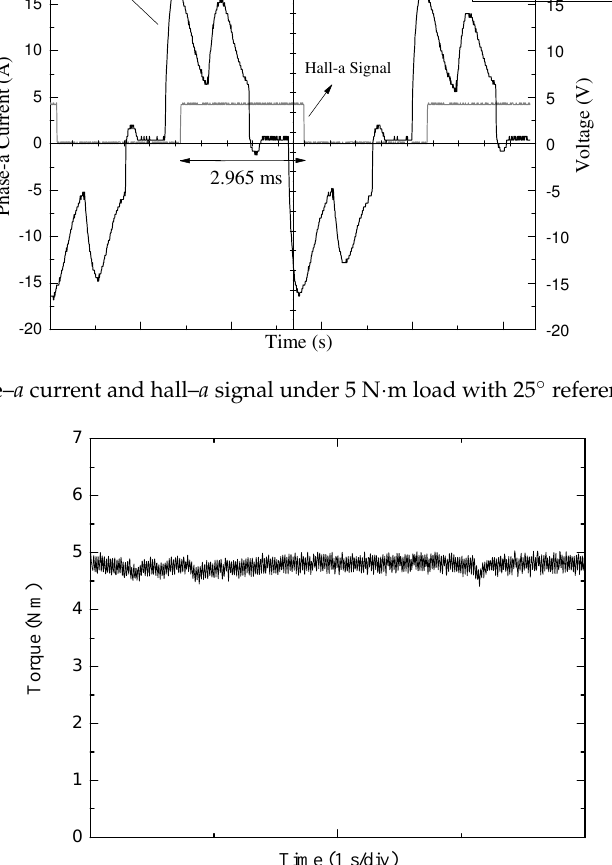
Figure 16. Torque response under 5 N · m load with 25 ◦ .